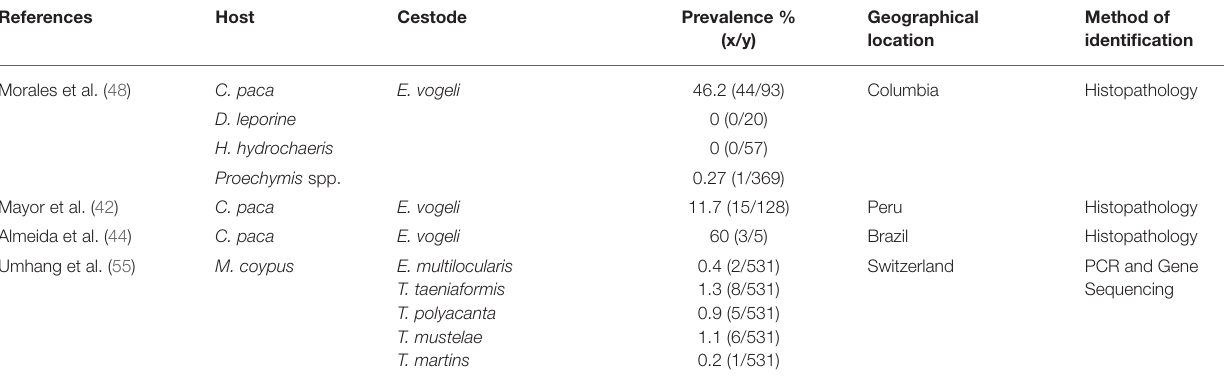
TABLE 2 | Prevalence of immature cestodes of hystricomorphic rodents and various geographical